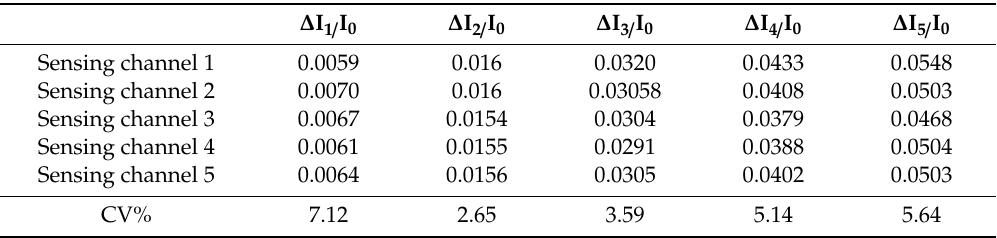
Table 5. The reproducibility of detecting anti-DNP / DNP binding by the multi-microchannel FOPPR sensor